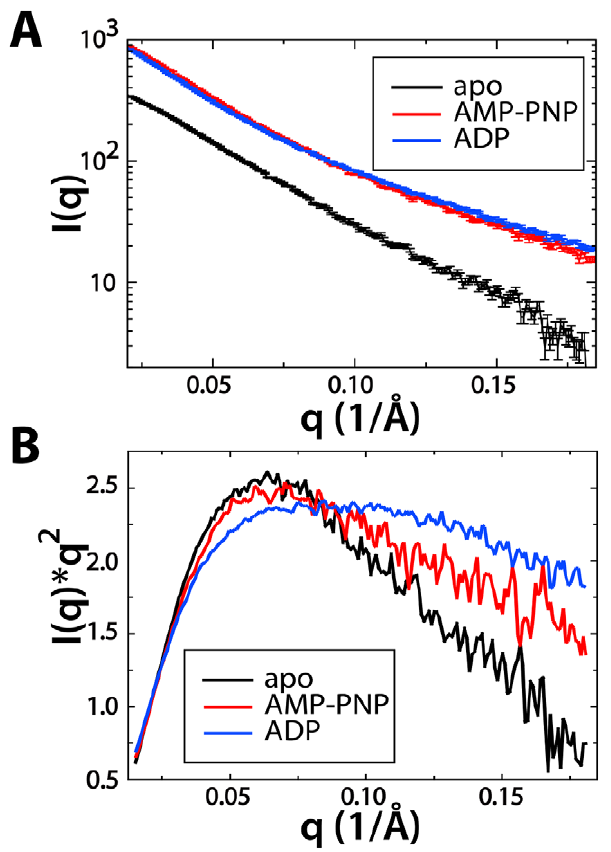
Figure 1. Small-angle X-ray scattering curves and Kratky plot of experimental data. A) Solution scattering data for apo Csk (black), AMP-PNP bound Csk (red), and ADP bound Csk (blue). B) Kratky plot of experimental solution scattering data colored in the same manner as A. Scattering data is normalized for ease of comparison in the plot.